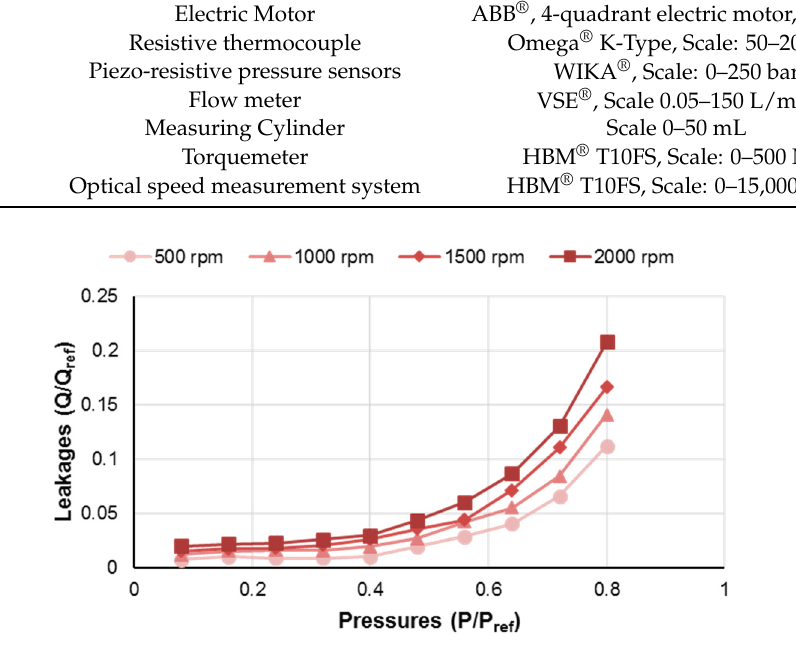
Figure 12. Measured drain leakages plotted for different operating conditions.